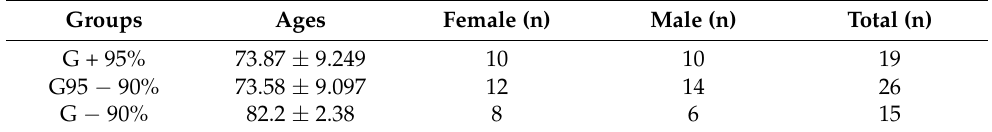
Table 1. Sex and age distribution per groups.